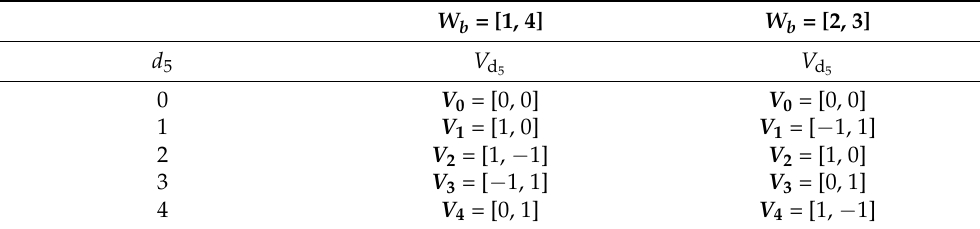
Table 3. The distortion vector table (DVT) for concealing 5-ary secret